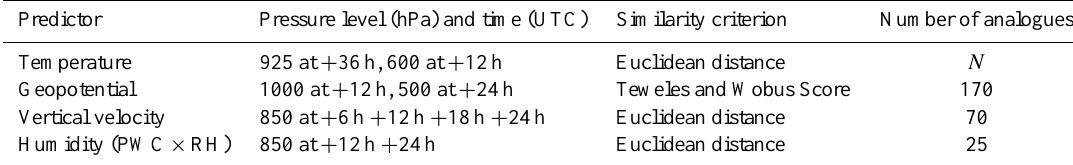
Table 1. Characteristics of SANDHY predictors. N depends on the length of the archive period. Predictor Pressure level (hPa) and time (UTC) Similarity criterion Number of analogues Temperature 925 at + 36h, 600 at + 12h Euclidean distance Geopotential 1000 at + 12h, 500 at + 24h Teweles and Wobus Score 170 Vertical velocity 850 at + 6h + 12h + 18h + 24h Euclidean distance Euclidean